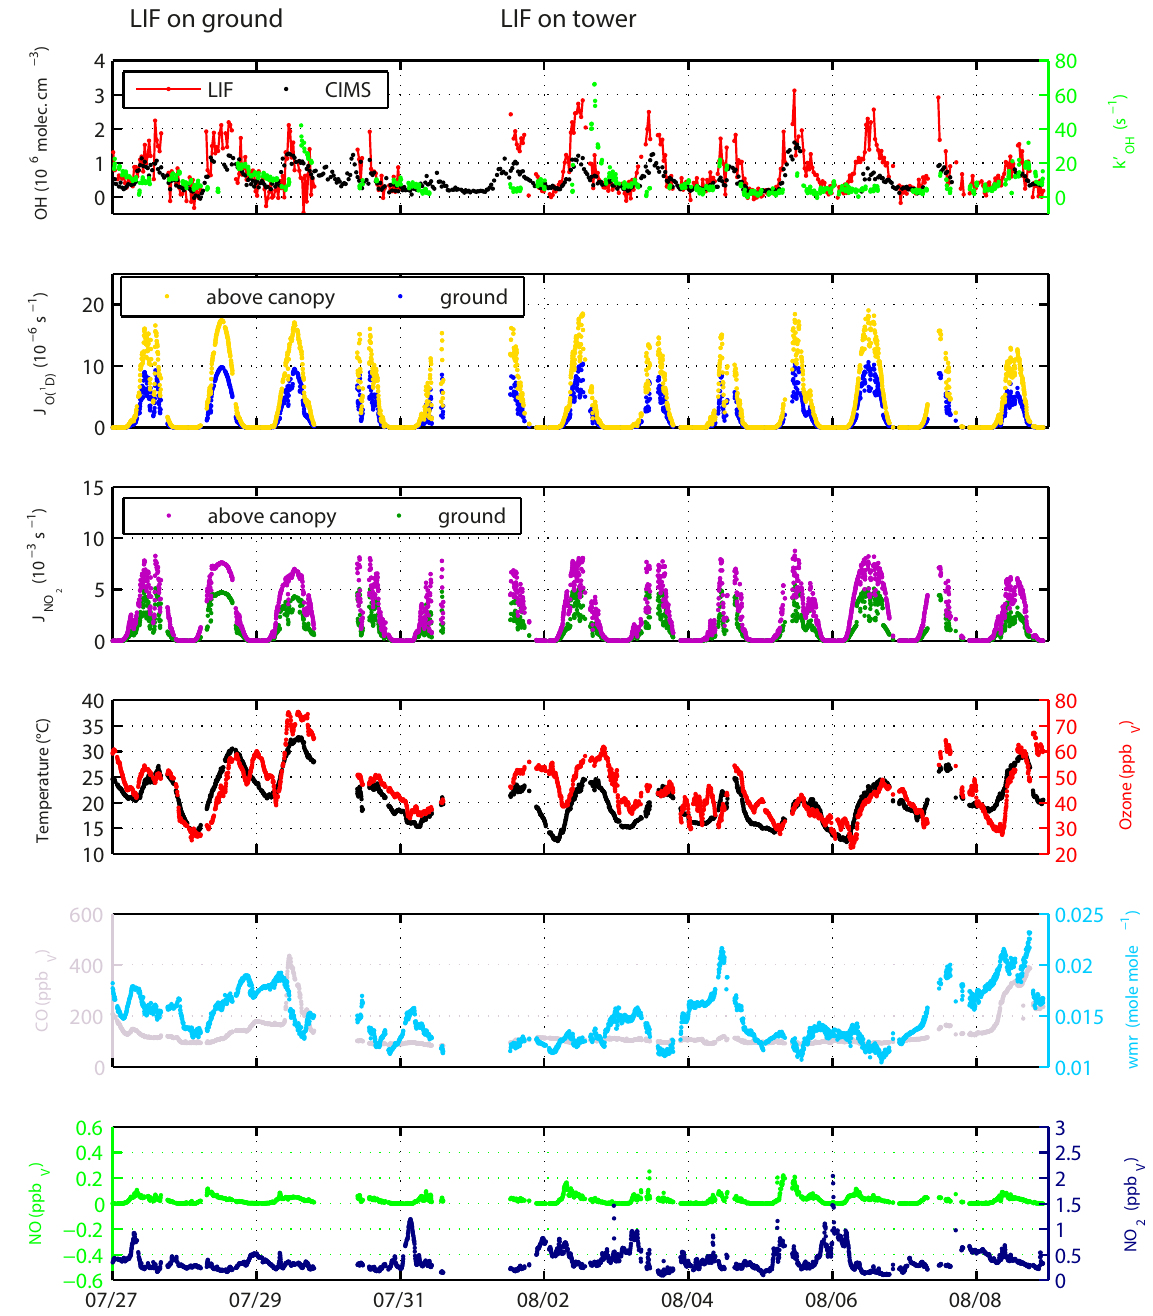
Figure 9. Time series of trace gas species and meteorological parameters during HUMPPA-COPEC-2010 observed above canopy or noted